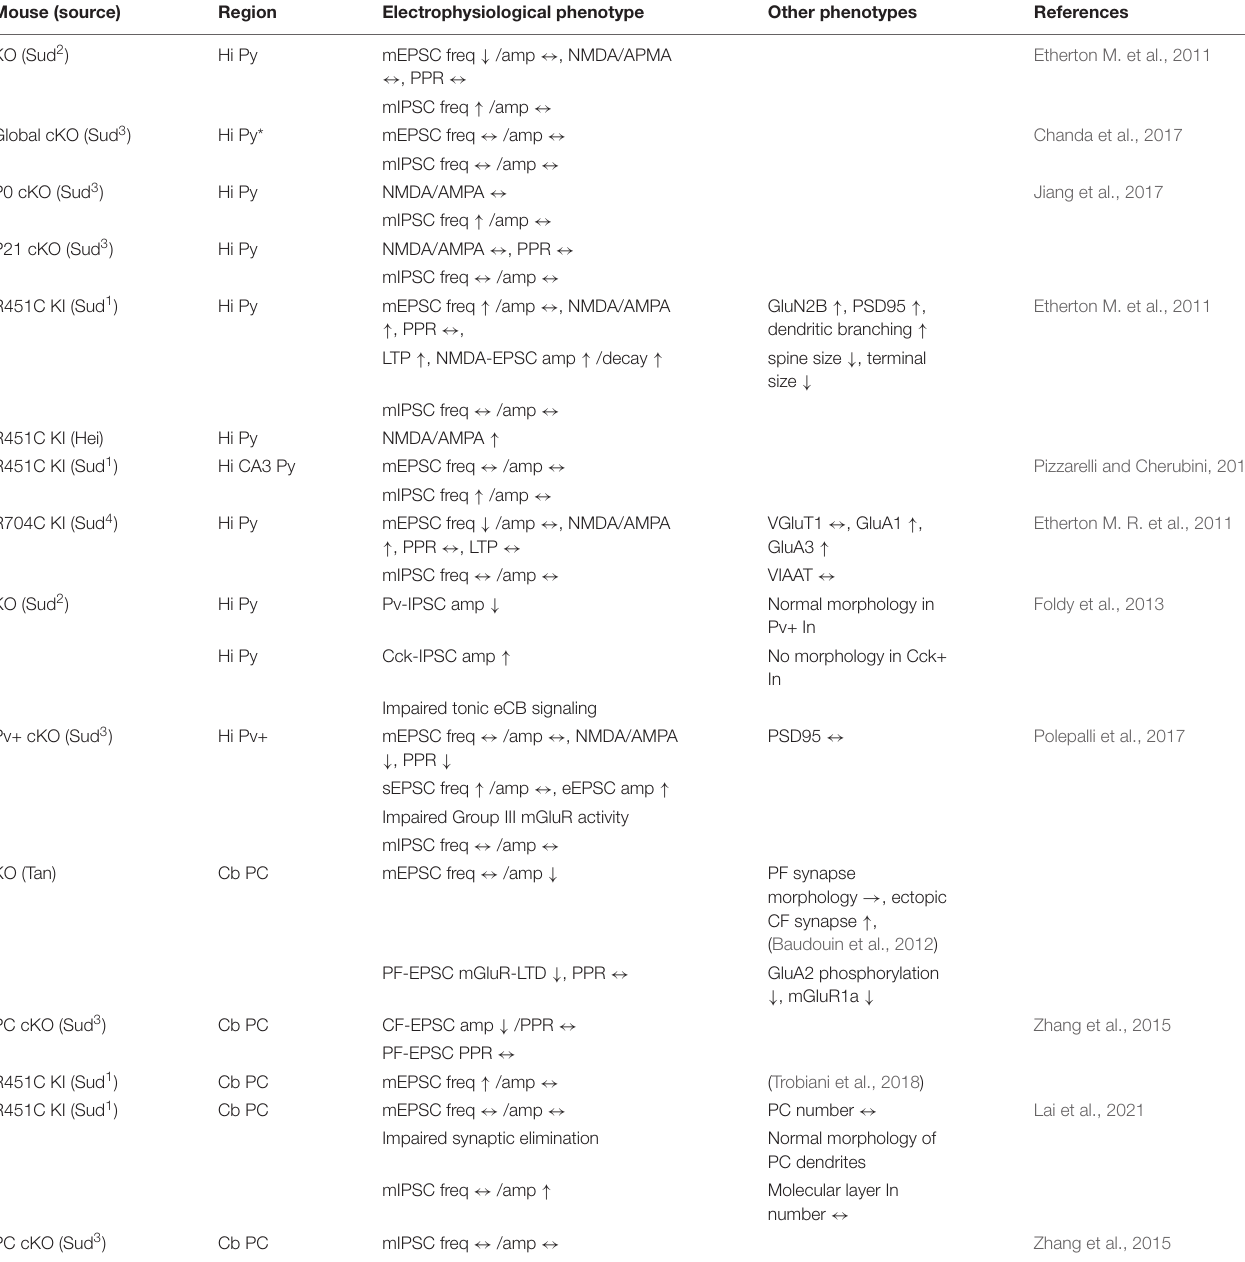
TABLE 1 | Summary of electrophysiological and other phenotypes in Nlgn3 mutant mouse lines in the hippocampus and cerebellum. Mouse